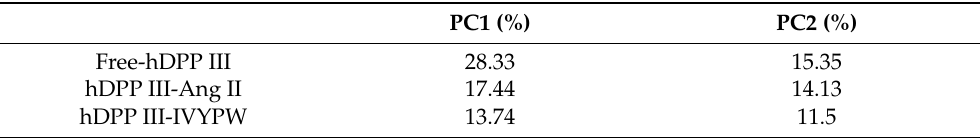
Table 3. The probabilities of PC1 and PC2 of the three